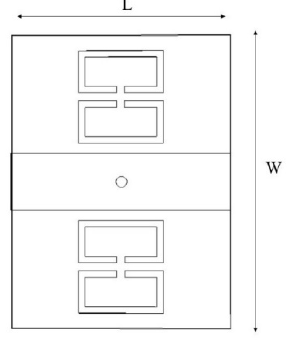
FIGURE.2. TOP VIEW OF BANDPASS FILTER USING SINGLE RESONATOR.